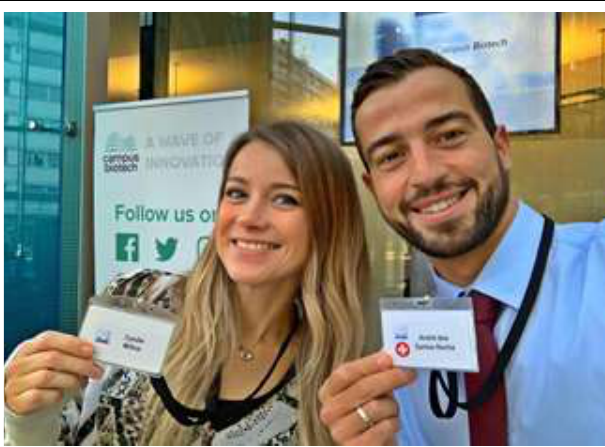
Figure 1 . Dr. André dos Santos Rocha, University of Geneva MD-PhD Student & EU MD/PhD Association Chairman. Pictured here with a Geneva EMPA Conference